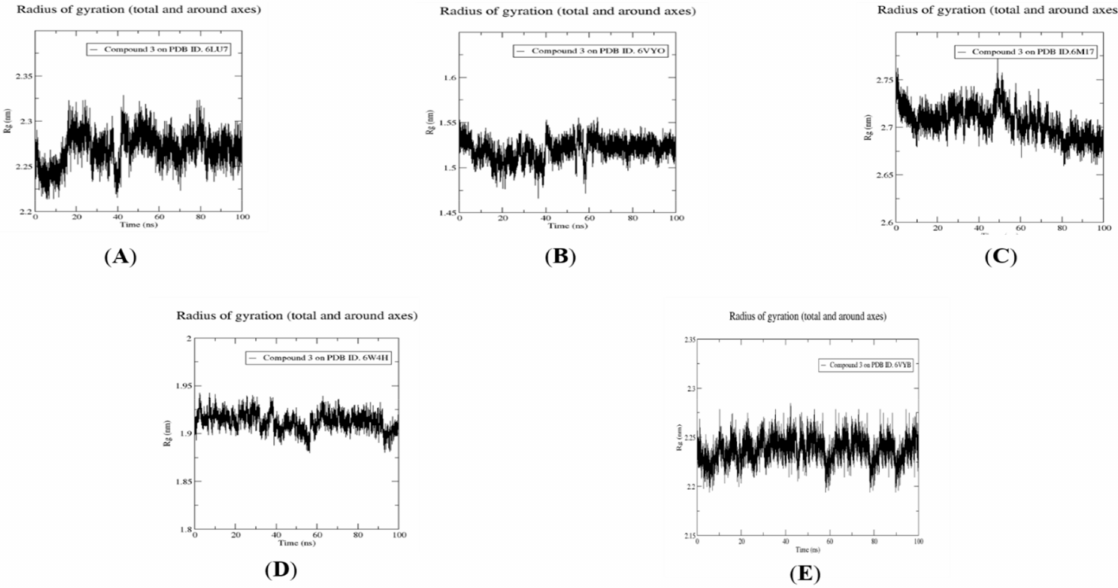
Figure 11. Dynamics of compound 3 bound to PDB ID: 6LU7 ( A ), 6VYO ( B ), 6M17 ( C ), 6W4H ( D ) and 6VYB ( E ), respectively. Radius of gyration analysis of compounds 3 against the five target